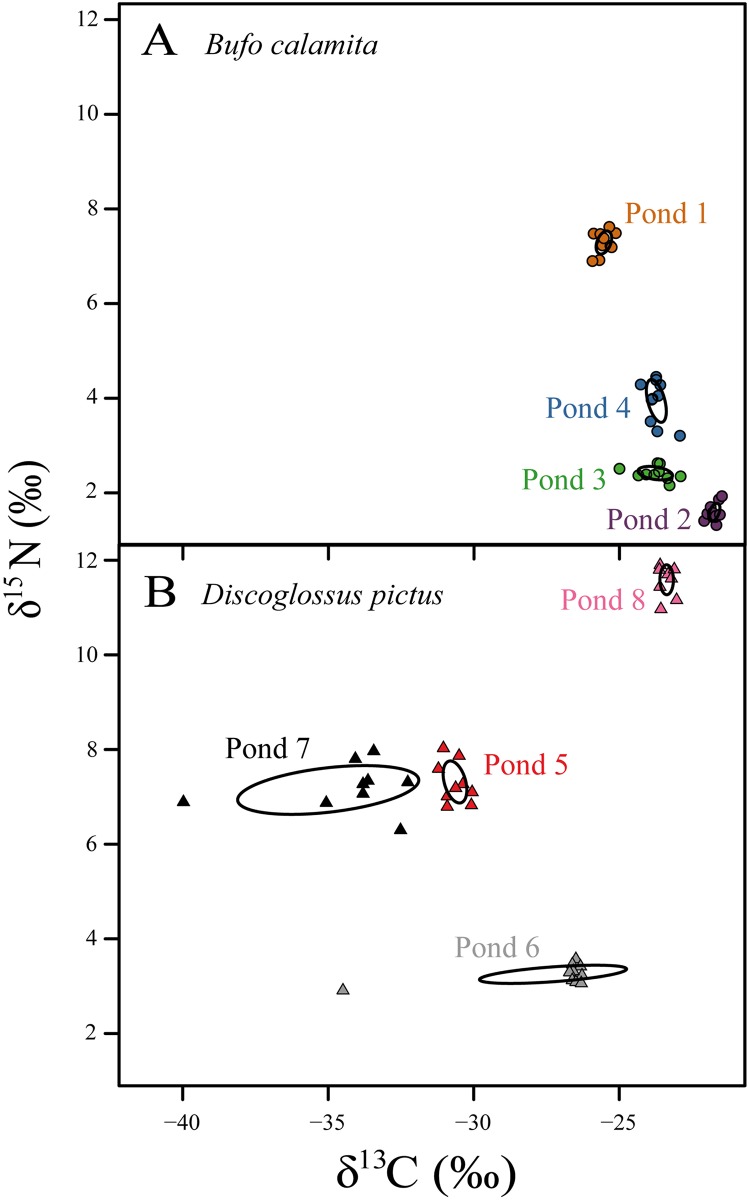
δ13C and δ15N values and standard ellipse areas for the isotopic niches of B. calamita (A) and D. pictus (B) in each pond under non-sharing conditions.